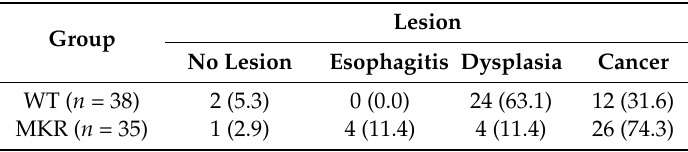
Table 1. Incidence of esophageal pathological changes in wild-type (WT) and hyperinsulinemic (MKR) mice with duodenal reflux. Data show the numbers of mice, with percentages in